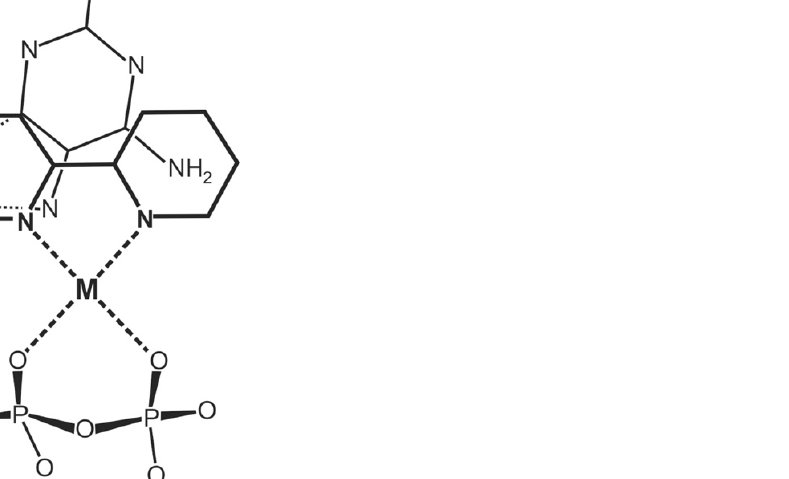
Figure 14. Probable schematic structure in solution of an intramolecular stack in the Cu(bpy)(ATP) 2 − complex [105]; adapted from similar structures for Cu(bpy)(AMP), as shown in Refs [124–126].